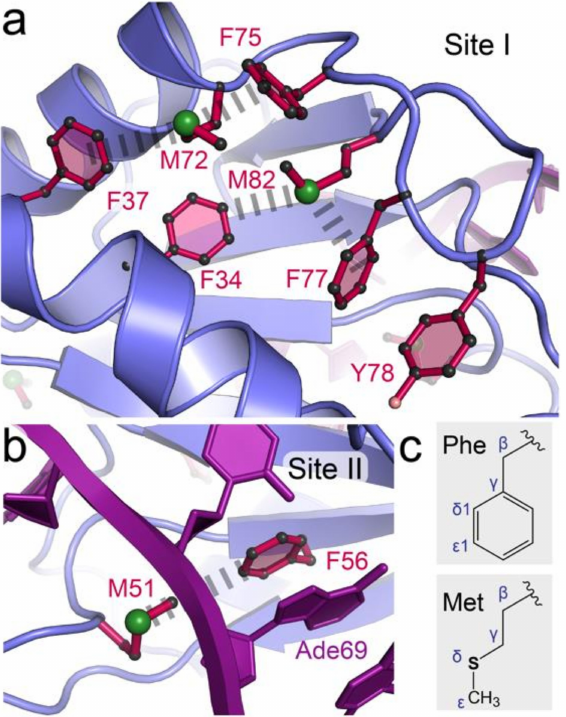
Figure 2. Rationale for Phe-to-Met mutations in U1A based on S– π interactions in the hydrophobic core. ( a ) Close-up view of the ‘site I’ hydrophobic core depicting aromatic and methionine residues. Hash marks indicate putative S- π interactions between specific Phe and Met residues. Here and in panel b , protein coordinates were derived from PDB entry 1urn, referred to as dmU1A, due to the double-mutations made to the protein for crystallization [56,57]. ( b ) Close-up view of the site II hydrophobic core on the side of the β -sheet opposite site I. F56 interacts directly with M51 and Ade69 of hpII. ( c ) Drawing of the phenylalanine and methionine sidechains to compare their relative sizes and atomic